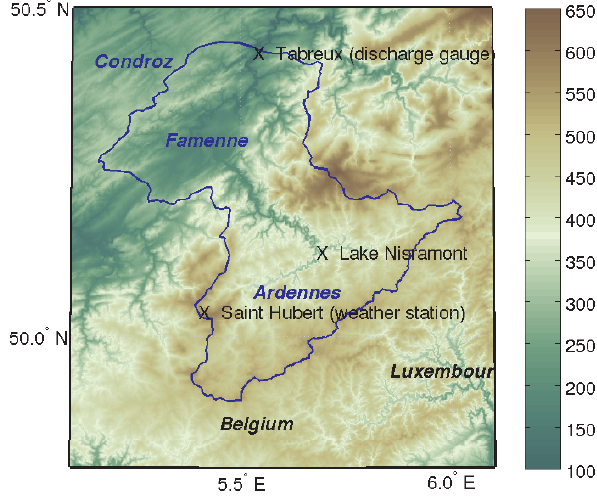
Fig. 1. Digital elevation model of the Ourthe catchment. Also shown are the discharge measuring gauge at Tabreux, the weather station in St. Hubert and Lake Nisramont, indicated by black crosses. The color scale indicates elevation above sea level in me-